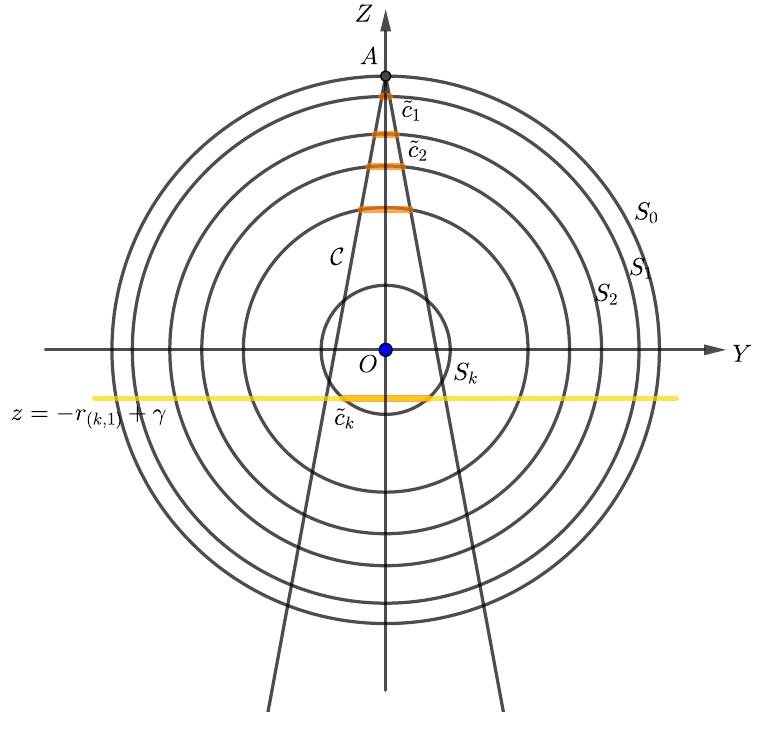
Figure 5. The cross section at the YZ -plane for the concentric spheres including a spherical circle of each layer and the cone C